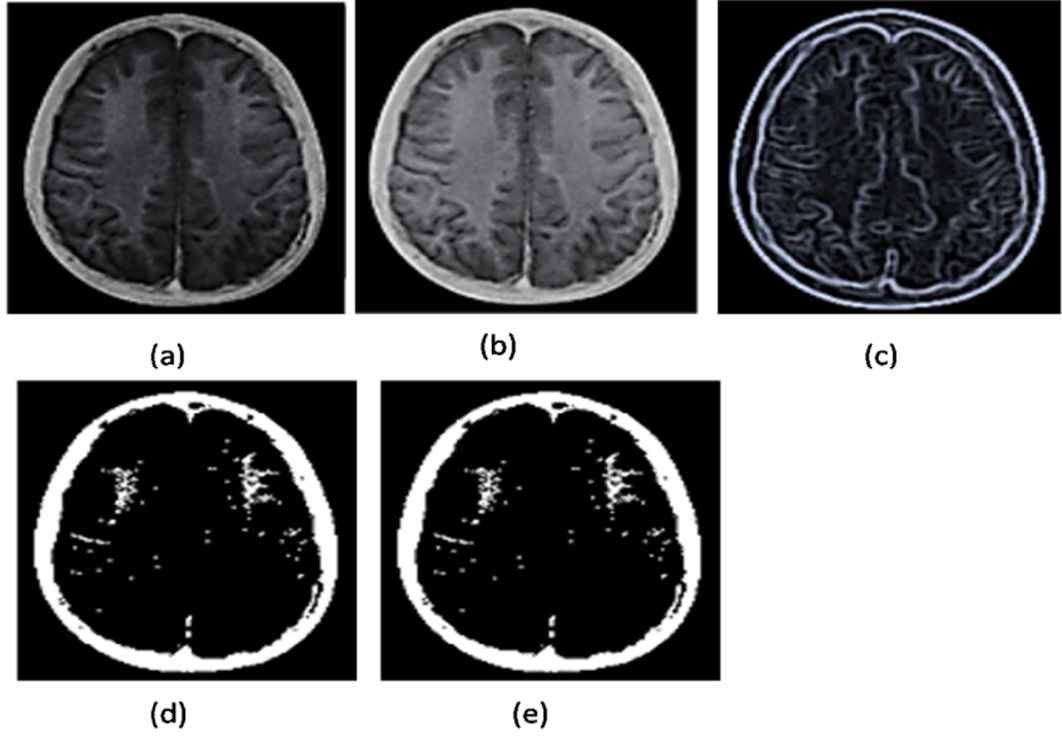
Figure 9. Processing and results of an image from Rider Neuro dataset. ( a ) Grayscale image; ( b ) segmentation; ( c ) morphological operations; ( d ) ROI selection and coloring; ( e ) no tissue identified.